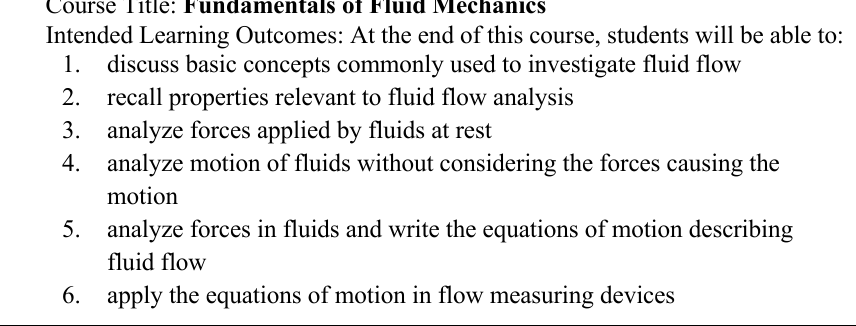
Fig. 4. Learning Objectives for Fundamental of Fluid